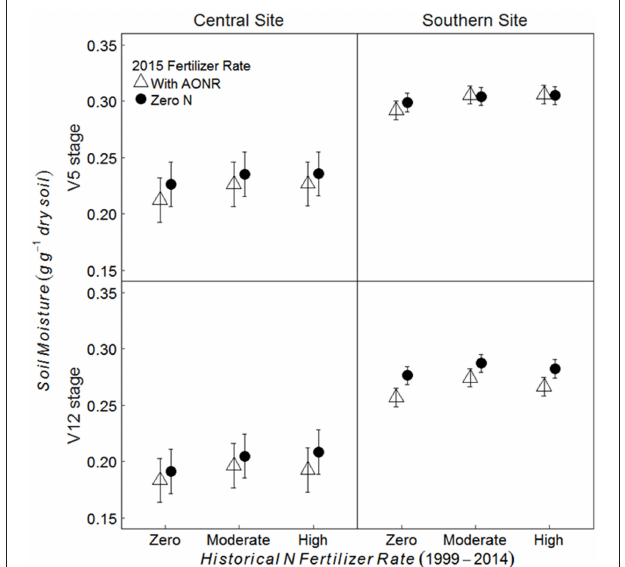
FIGURE 4 | Mean gravimetric soil moisture from 5 to 15cm at the V5 and V12 maize growth stages in continuous maize systems in central and southern Iowa in 2015. Experimental plots received one of three historical N fertilizer rates from 1999 to 2014 (zero, moderate, or high). Individual plots received the same N rate every year 1999–2014. In 2015, the historical N rate plots were split and received either zero N or the empirically determined long-term agronomic optimum N rate (AONR). Vertical bars represent 95% confidence